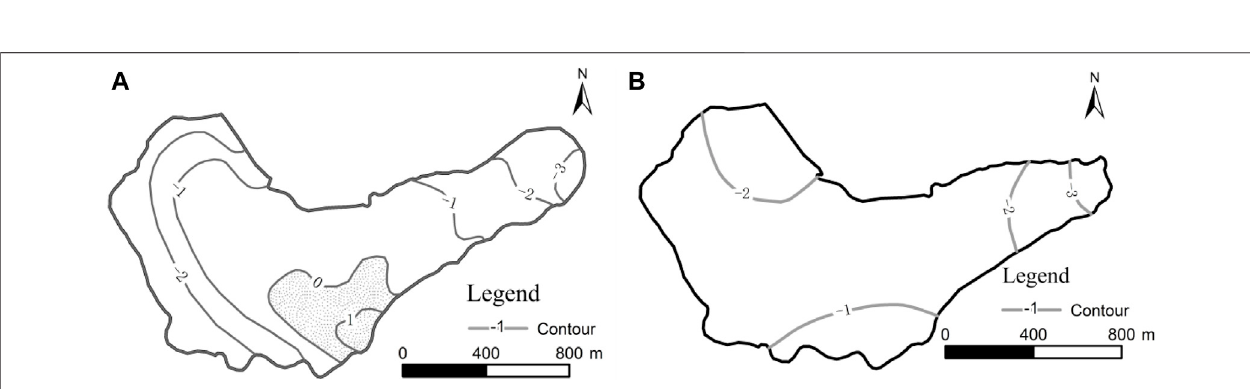
Frontiers in Earth Science |